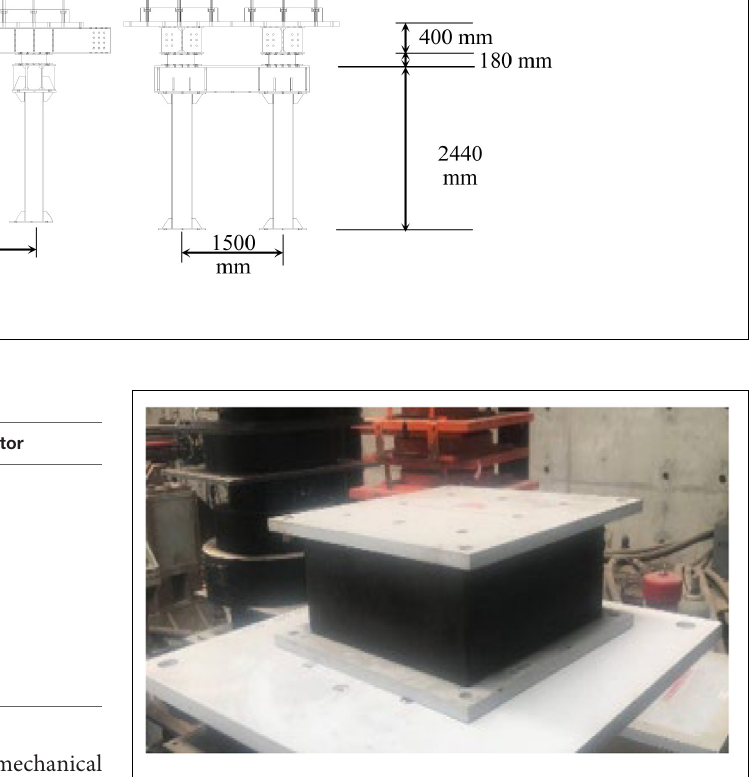
FIGURE 2 | Details of the